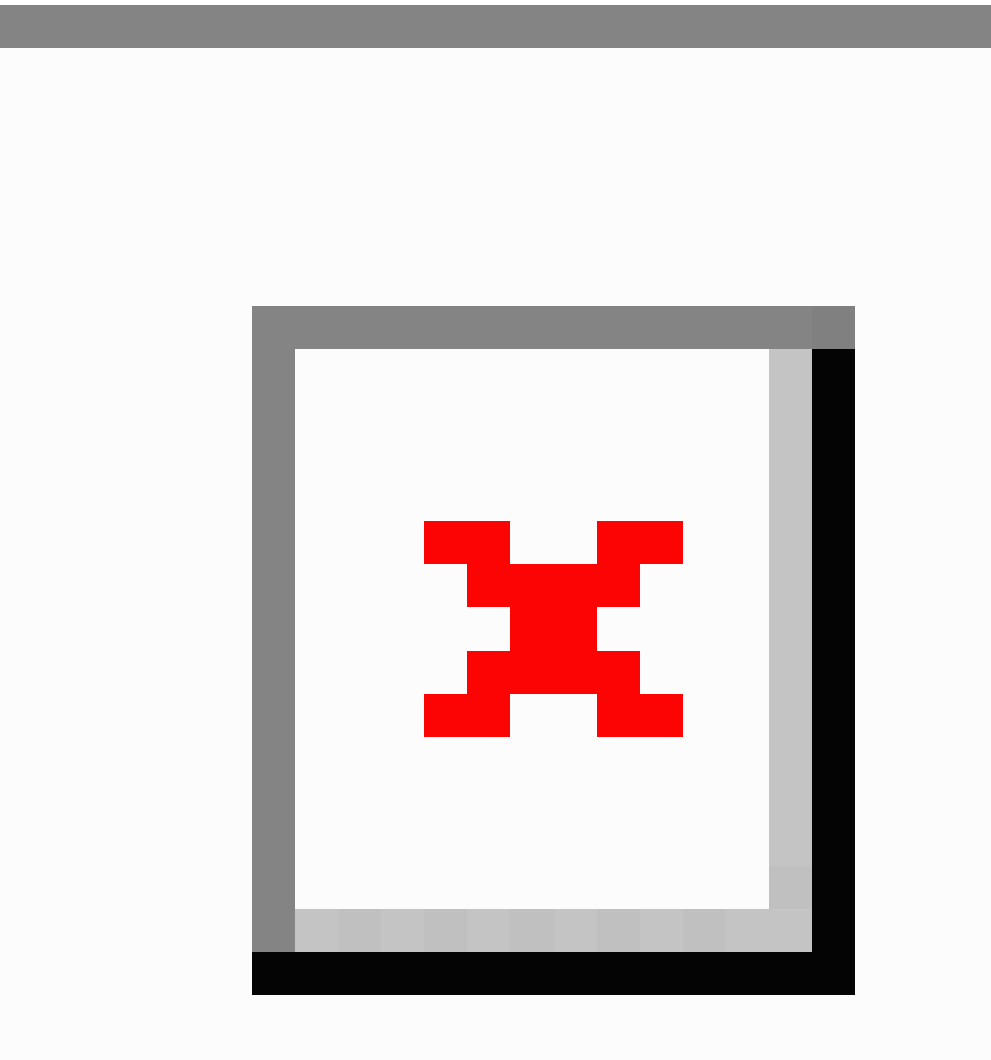
Figure 1. Pediatric Early Warning Score (PEWS) scores prior to emergent transfer. The ordered sequence of PEWS scores in the electronic medical record prior to PICU transfer are shown, indexed in the order they occurred, and the size of the data points is proportional to the score itself. Correct: score was recorded and accurate; Incorrect: score was recorded, but lower than the recalculated value; N/A: score was not